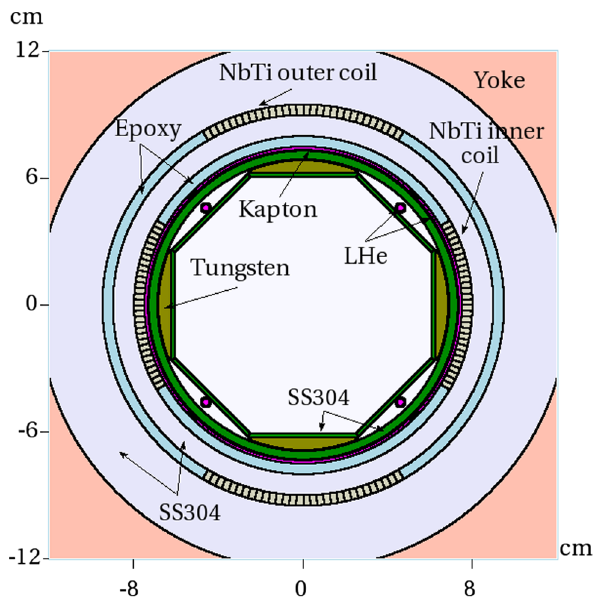
FIG. 4. Cross-sectional view of the FLUKA - MARS model in the central part of the MCBX